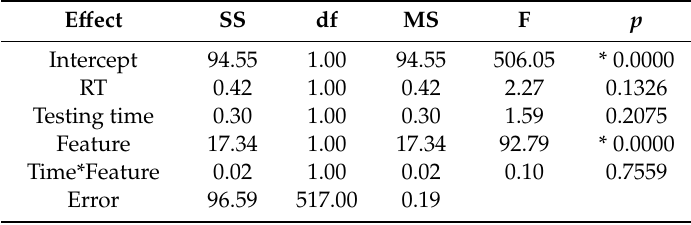
Table 10. Results of a linear model for the dependent variable—Accuracy for L2 English. E ff ect